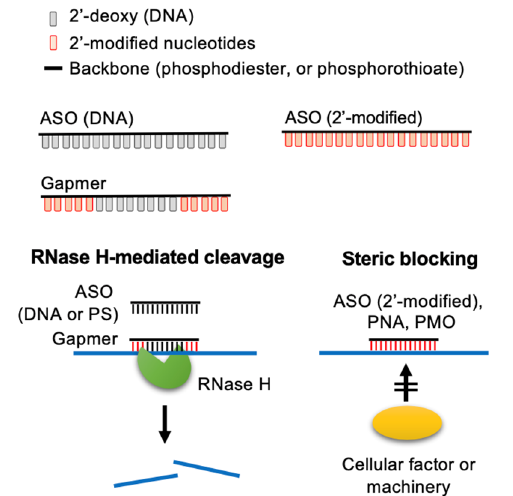
Figure 1. Molecular mechanisms of action of ASOs. ASOs can modulate the expression of target RNAs via two different mechanisms. Conventionally, ASOs cause RNase H-mediated cleavage of the target RNA. Additionally, 2 ′ -O-modified ASOs and neutral DNA mimics (PMOs and PNAs) act as a steric-blocker to prevent the access of cellular factors to the target RNA. Adapted from [15], Springer Nature Limited, 2020.